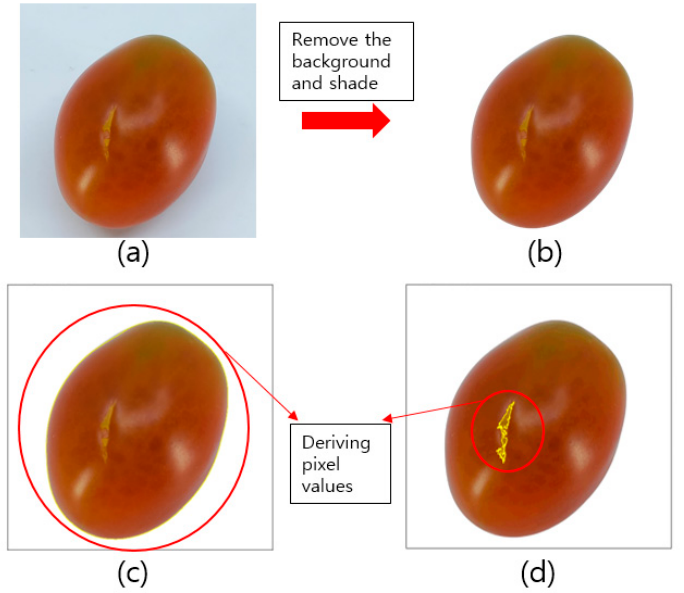
Figure 3. Analysis of damage to cherry tomatoes: ( a ) The original picture, ( b ) background and shadow removed from picture, ( c ) full pixel of cherry tomato, and ( d ) damage part highlighted.